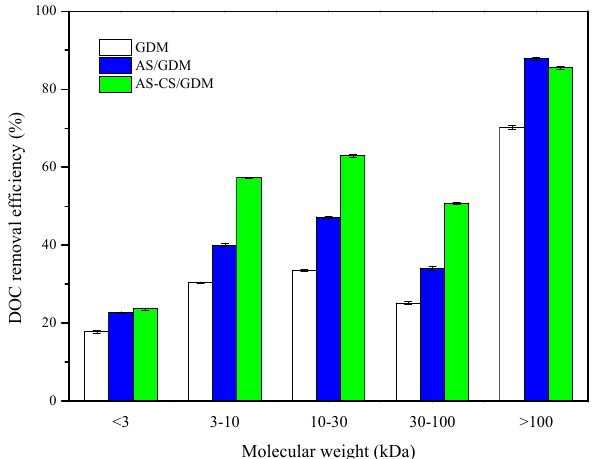
Figure 4. Dissolved organic carbon (DOC) removal efficiency of different molecular weights (MWs) of different permeate waters at the 27th day of the experiment.